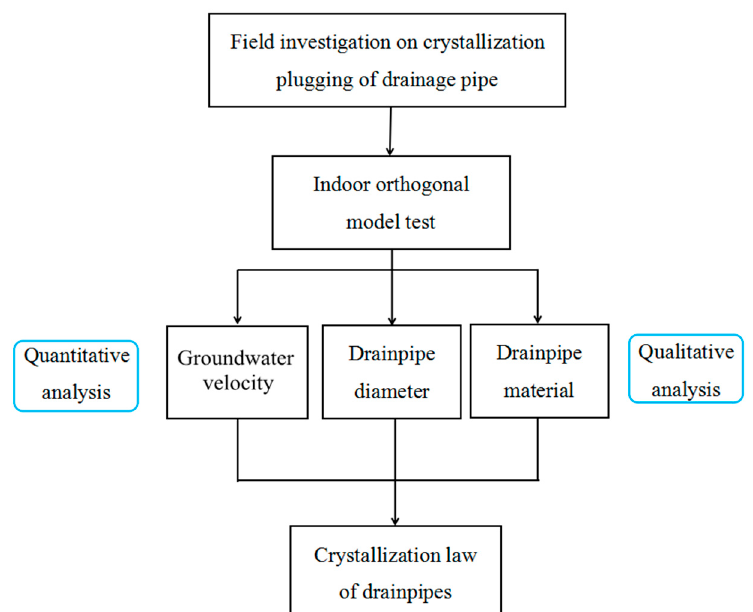
Figure 2. Research technology